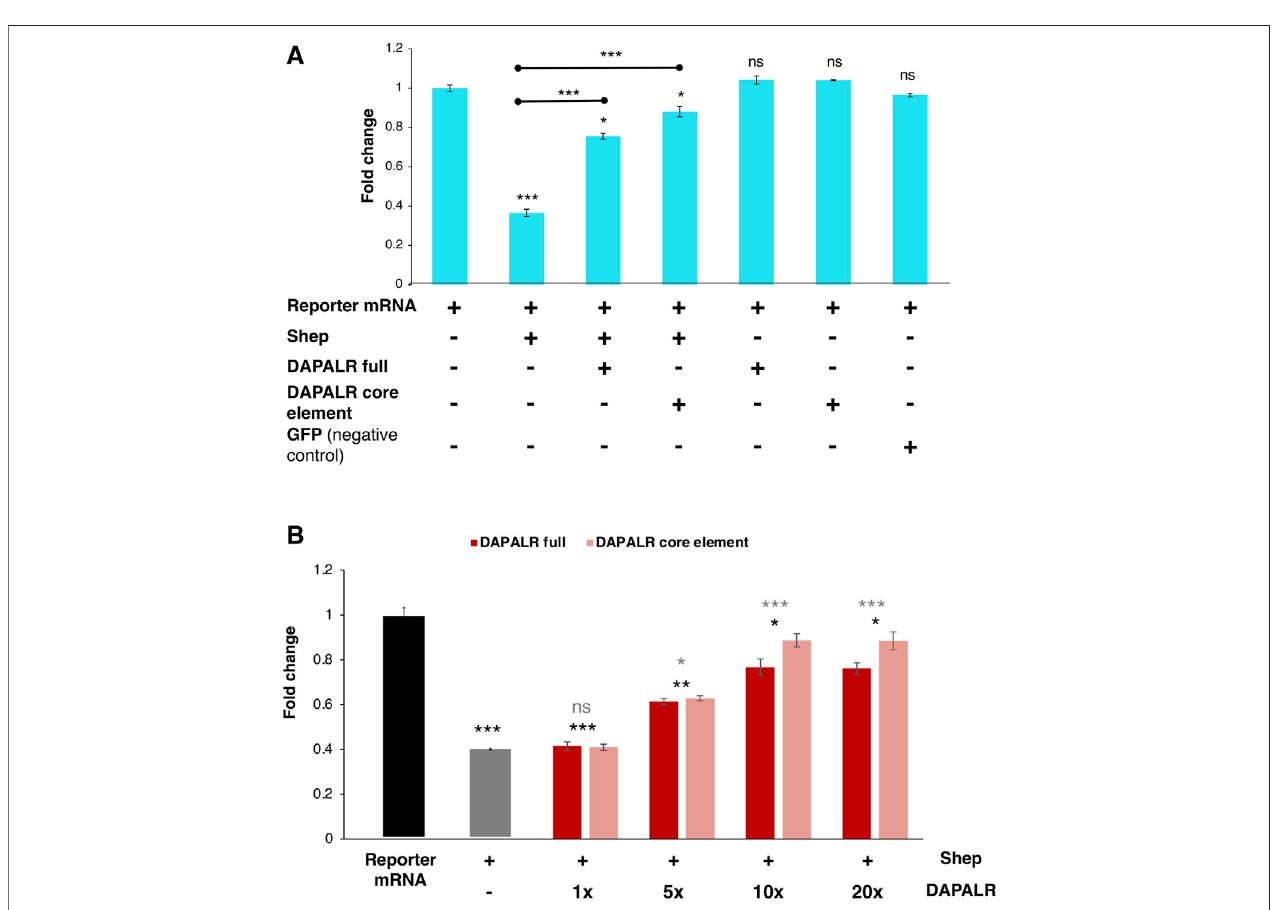
FIGURE 13 | Dsx1 post-transcription regulation by DAPALR and Shep in vitro . (A) Relative luciferase activity after in vitro translation assay of Dsx1 5 ′ UTR-Luc reporter mRNA with intact TGE upon addition of Shep mRNA, DAPALR full RNA, DAPALR core element, and GFP mRNA (negative control). Samples were compared against the expression of the Dsx1 5 ′ UTR-Luc reporter mRNA without the addition of any other mRNAs. The endpoints of the line above the bars show which samples were additionally compared statistically. (B) Relative luciferase activity after in vitro translation assay of Dsx1 5 ′ UTR-Luc reporter mRNA with Shep and different concentrations of full region of DAPALR and its core element. Error bars indicate the standard error of the mean, n = 3. Black asterisks show signi fi cant statistics compared with the expression of the Dsx1 5 ′ UTR-Luc reporter mRNA. Gray asterisks show signi fi cant statistics compared with the Reporter mRNA with Shep . Error bars indicate the standard error of the mean, n = 3. * p < 0.05, ** p < 0.01, *** p < 0.001, ns: not signi fi cant (Student ’ s t -test). Adapted from Perez et al. (2021).